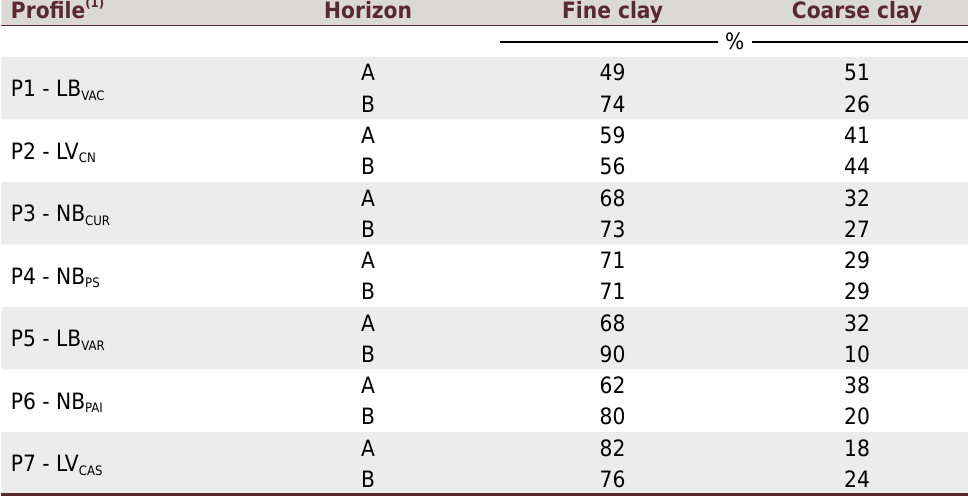
Table 6. Quantification of the fine and coarse clay sub-fractions for the A and B horizons of the profiles studied. Profile